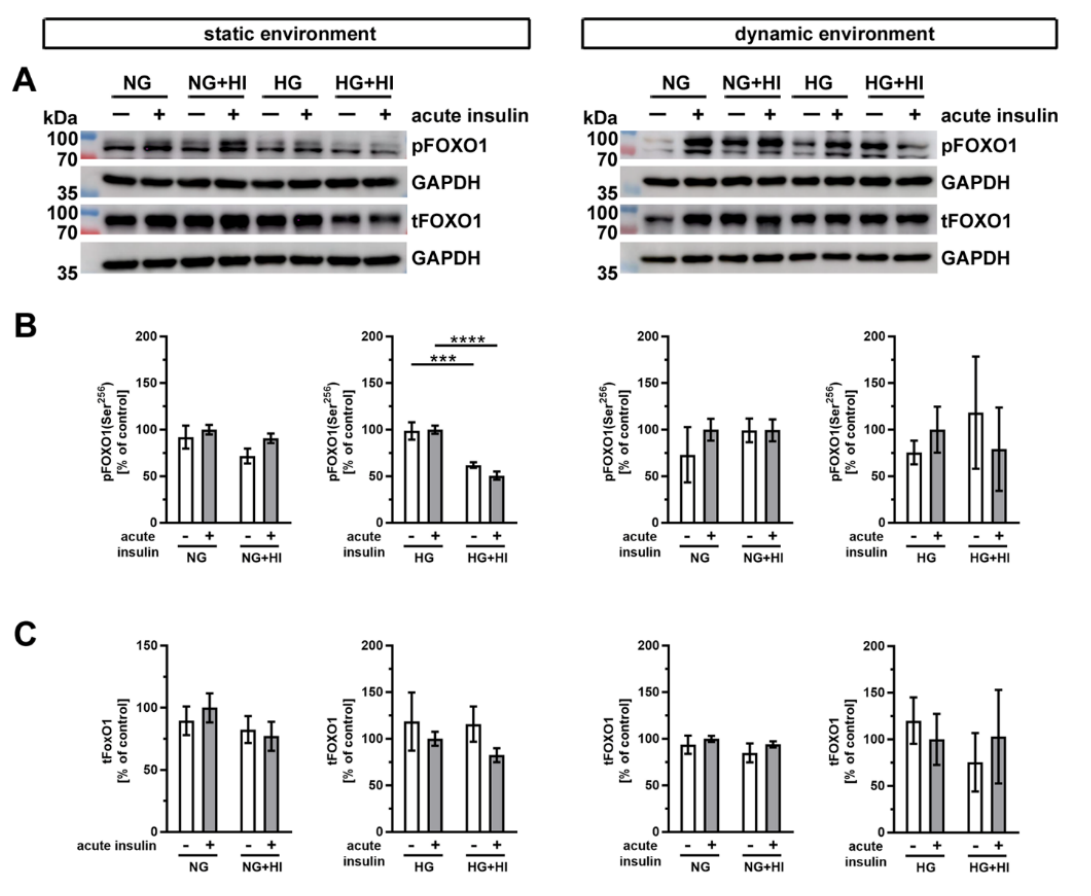
Figure 9. Activation of FOXO1 signaling. ( A ) Representative images of the Western blot analysis of FOXO1 show the phosphorylation level and respective total protein expression after chronic diabetic conditions under static environment versus dynamic flow cultivation. Lanes of protein ladders represent 70 kDa and 100 kDa (pFOXO1 and tFOXO1) as well as 35 kDa (GAPDH). ( B ) Significant effects of HI and HG treatment on the phosphorylation level of FOXO1 were only visible in statically cultivated AV tissue without and with acute insulin stimulation. ( C ) The expression of total FOXO1 was independent from chronic HI and HG treatment in both cultivation environments (static versus dynamic flow). Data were normalized to GAPDH and subsequently related to NG with acute insulin stimulus. n = 3–6; ***: p < 0.001; ****: p < 0.0001; kDa: kilodalton; pFOXO1: phosphorylated forkhead box protein O1; tFOXO1: total forkhead box protein O1;